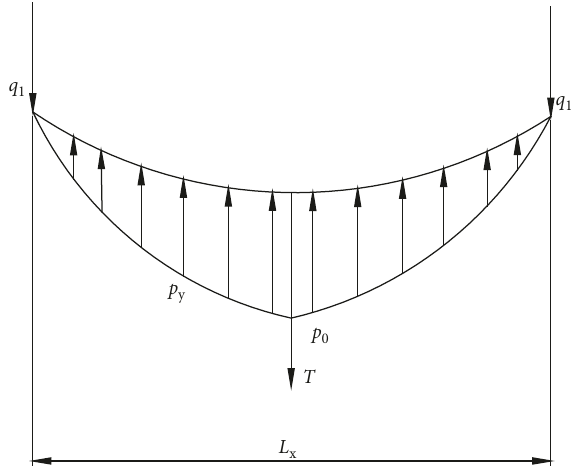
Figure 5: Relationship diagram of the roof pressure and UST parameters.